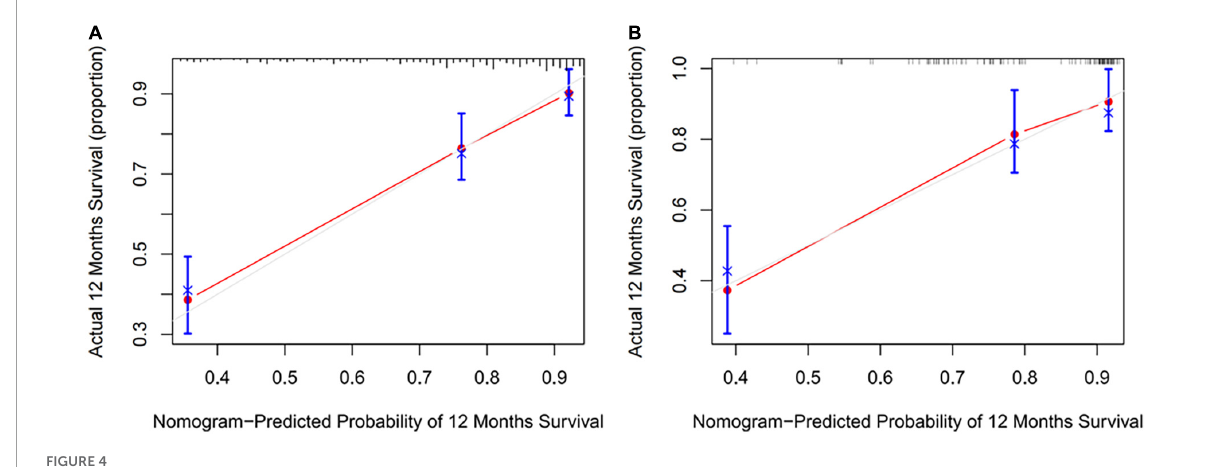
FIGURE4 The calibration curves were predicted by nomogram in development cohort (A) and validation cohort (B) .